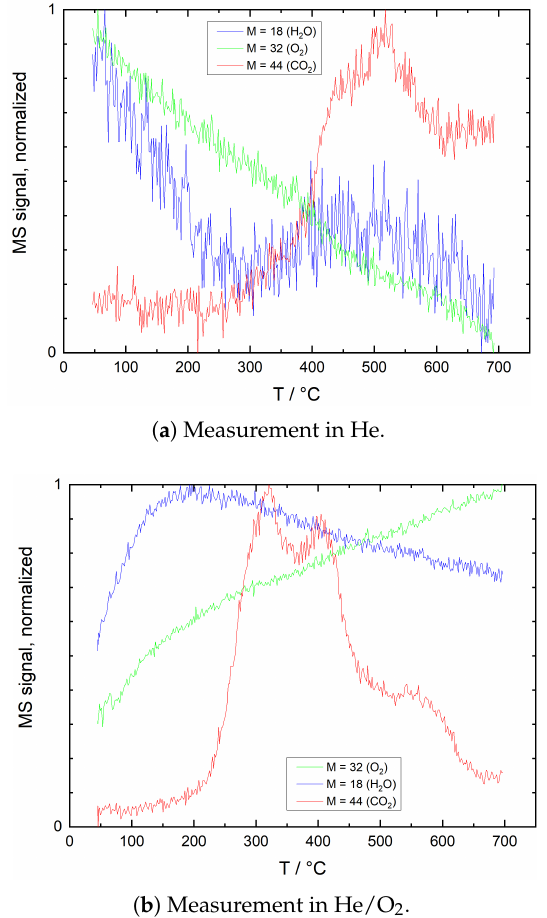
Figure 6. TPD plots, reference measurements without sample in ( a ) He and ( b ) He+12.5vol% O 2 (He/O 2 ). Mass spectrometer signals for mass numbers 32 (O 2 ), 18 (H 2 O) and 44 (CO 2 ) have been normalized individually for better